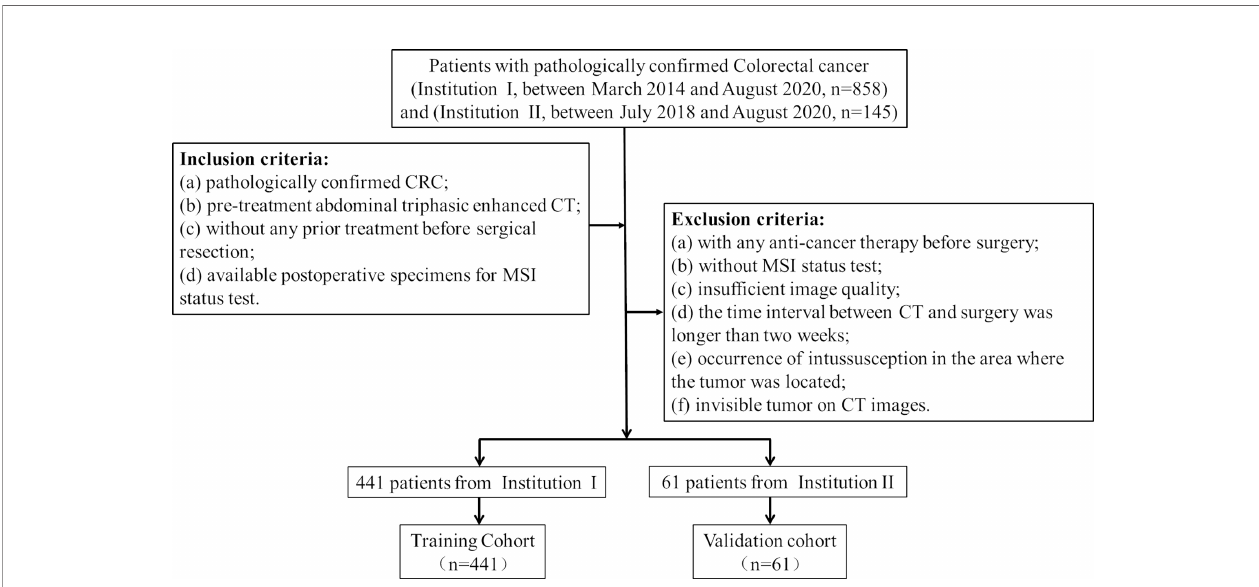
FIGURE 1 | Patient inclusion and exclusion details and the patient recruitment